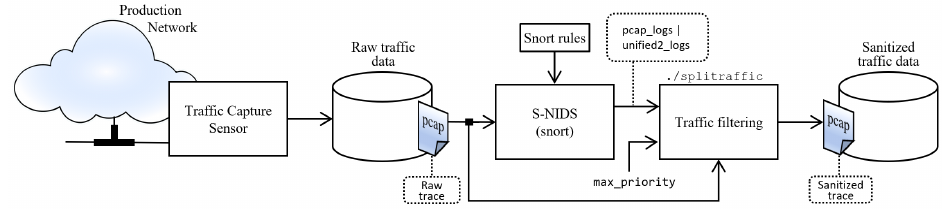
Figure 3. Diagram for the recollection and cleansing network traffic